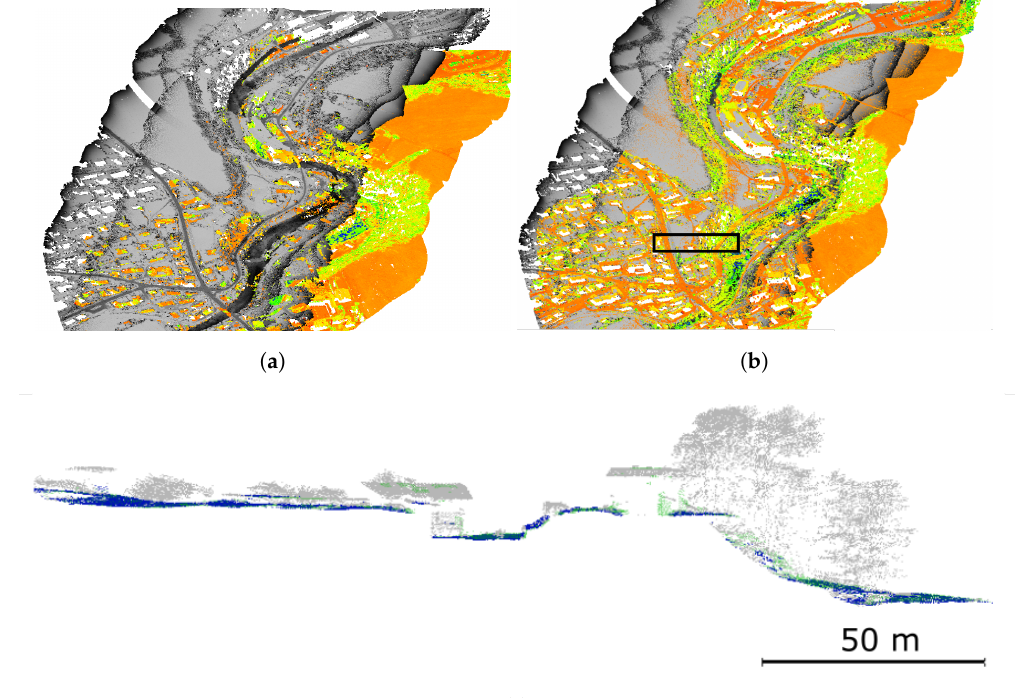
Figure 7. Result of the proposed approach shown on the fourth scene. ( a ) Overview of the fourth scene with initial transformation. ( b ) Overview of the fourth scene with registration result. ( c ) Profile view of the marked area in ( b ). Shown data are the original data of 2012 and the data of 2017 downsampled to 0.5 m GSD. The color representation is the same as in Figure